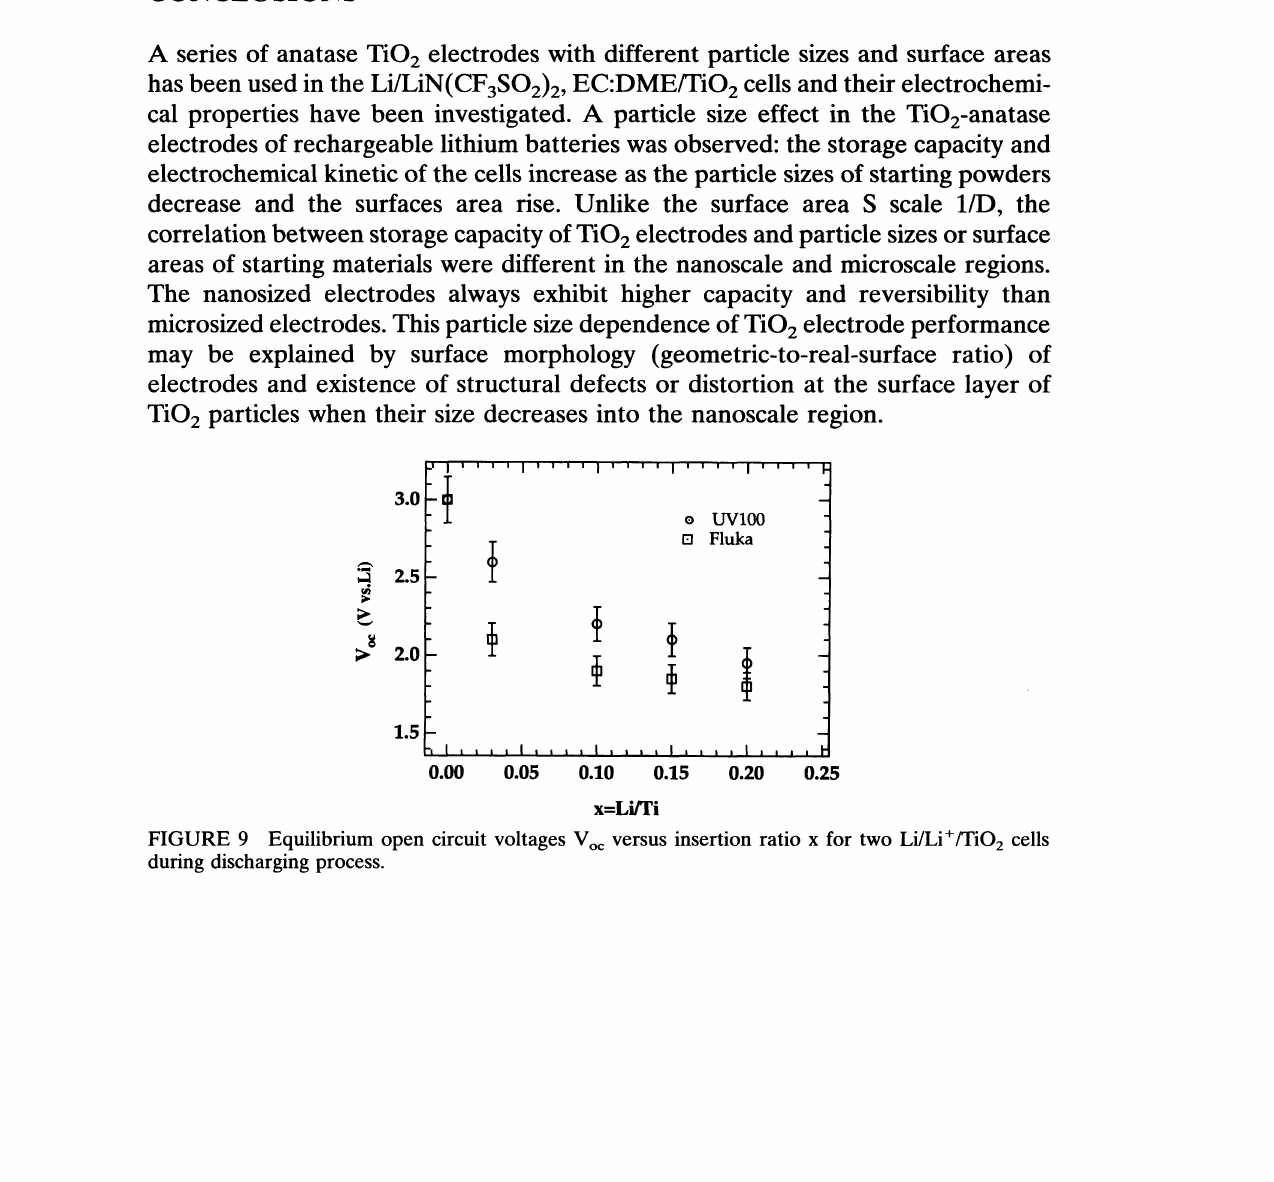
FIGURE 9 Equilibrium open circuit voltages Voc versus insertion ratio x for two Li/Li+/TiO2 cells during discharging